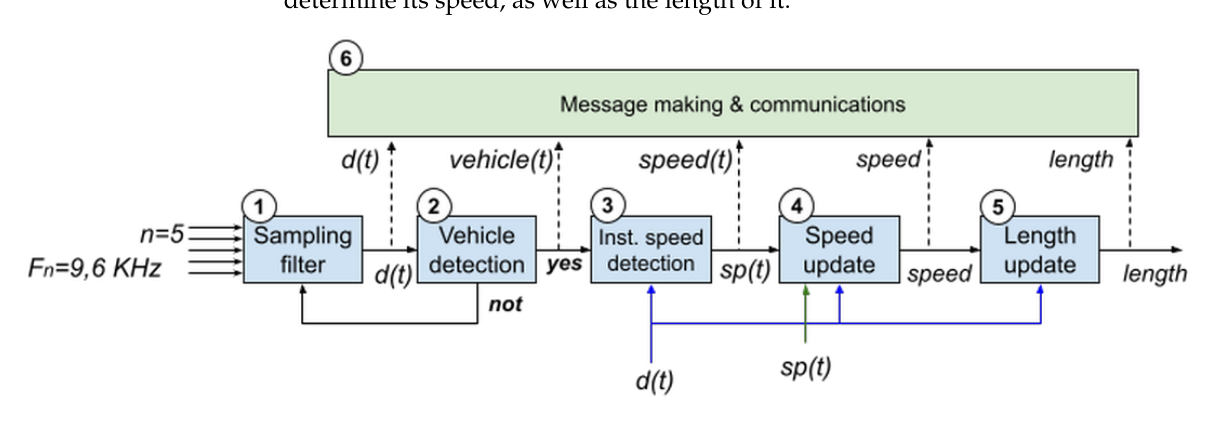
Figure 6. Phases performed by a module to detect and characterise a